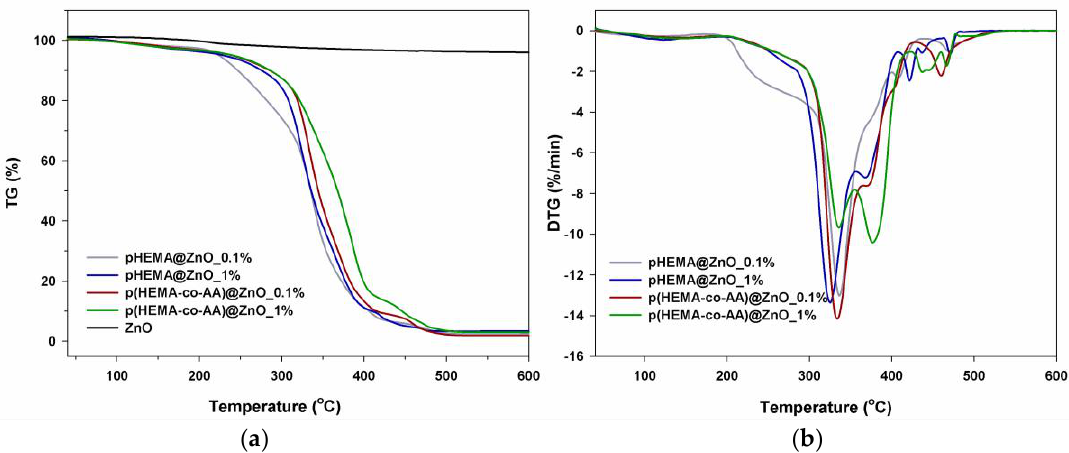
Figure 5. Thermal degradation curves of polymer-ZnO composites as well as ZnO powders as control sample (curve in black). ( a ) Thermogravimetry (TG) analysis and ( b ) Differential thermogravimetric (DTG) measurement.